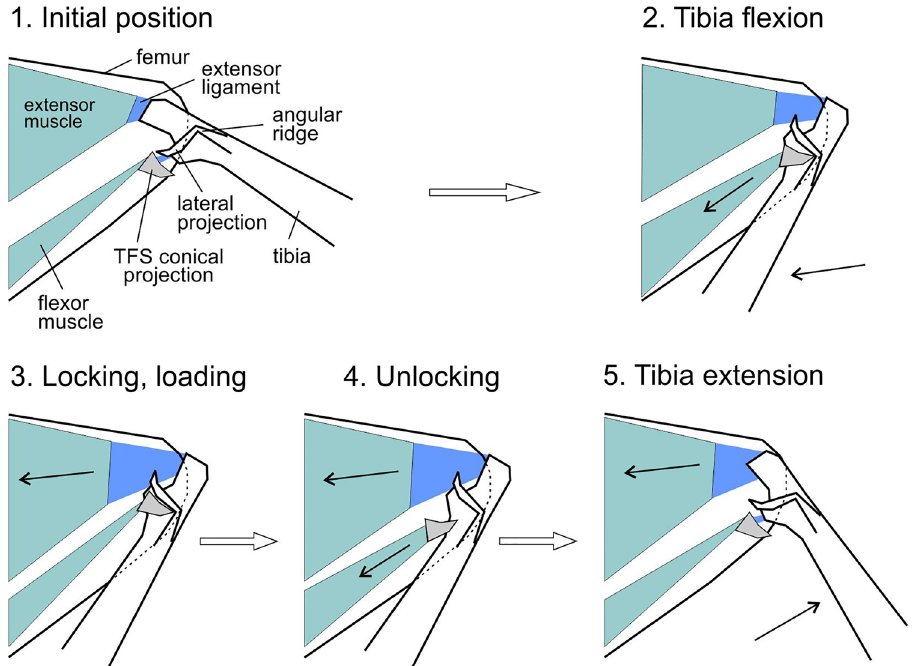
Figure 8. Scheme of the jumping process depicting its main phases. TFS tibial flexor sclerite. Detailed description of the jumping according to phases see in the “Discussion”. White arrows show the direction of phases; black arrows inside the muscles show the direction of muscle contraction, black arrows at the tibia in the phase 2 and 5 show the direction of tibial movement, flexion and extension